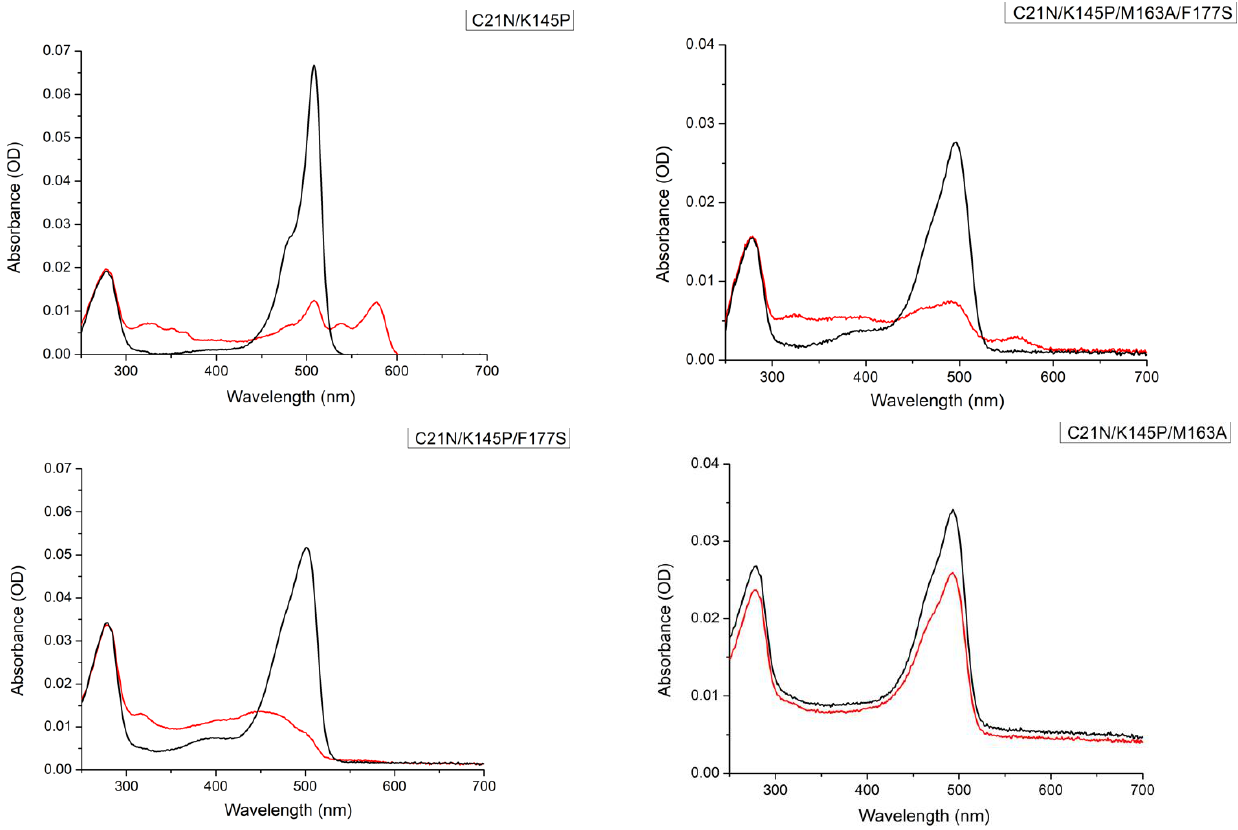
Figure 1. Absorbance spectra before (black line) and after (red line) 10 min of 400 nm illumination of the protein solutions measured in 20 mM Tris – HCl, 150 mM NaCl pH 7.4 for C21N/K145P, C21N/K145P/M163A/F177S, C21N/K145P/F177S, and C21N/K145P/M163A mSAASoti variants. We also measured fluorescence lifetimes (Table 3) of both green and red forms for the new mutant forms. Green forms of mutants with substitutions in the vicinity of the chromophore (M163, F177) had a bi-exponential nature (Equation (1)) of the fluorescence decay, and the values of the average fluorescence lifetime ( τ mean ) became shorter compared to the wild type mSAASoti. The bi-exponential dependency of the fluorescence decays may be caused by the existence of various radiating conformers at the ns scale. Fluorescence lifetimes of the red forms became longer than the original red mSAASoti in the case of new